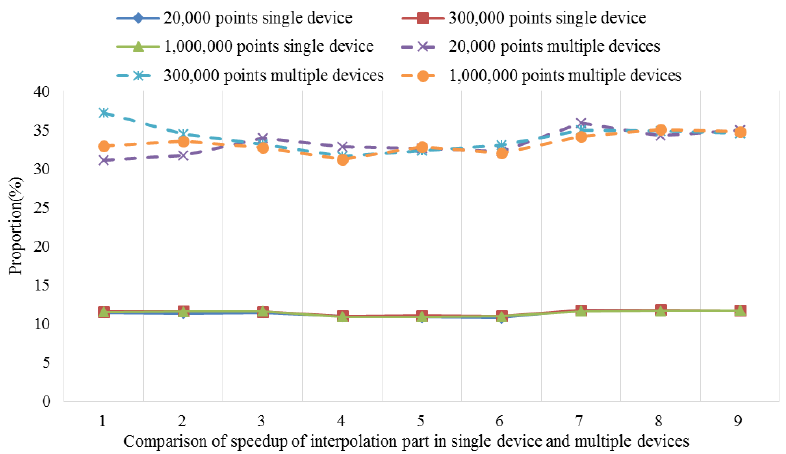
Figure 10. Comparison of the speedup obtained using single/multiple cards on Shelob ( 𝑆𝑝𝑒𝑒𝑑𝑢𝑝